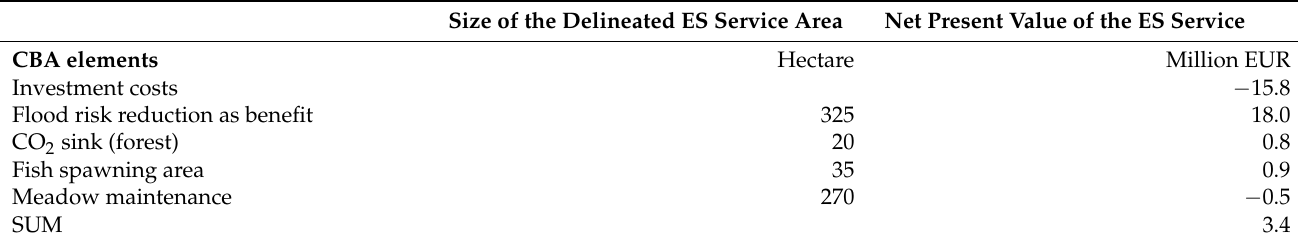
Table 2. CBA results for ecosystem service elements. Legend: Source of data